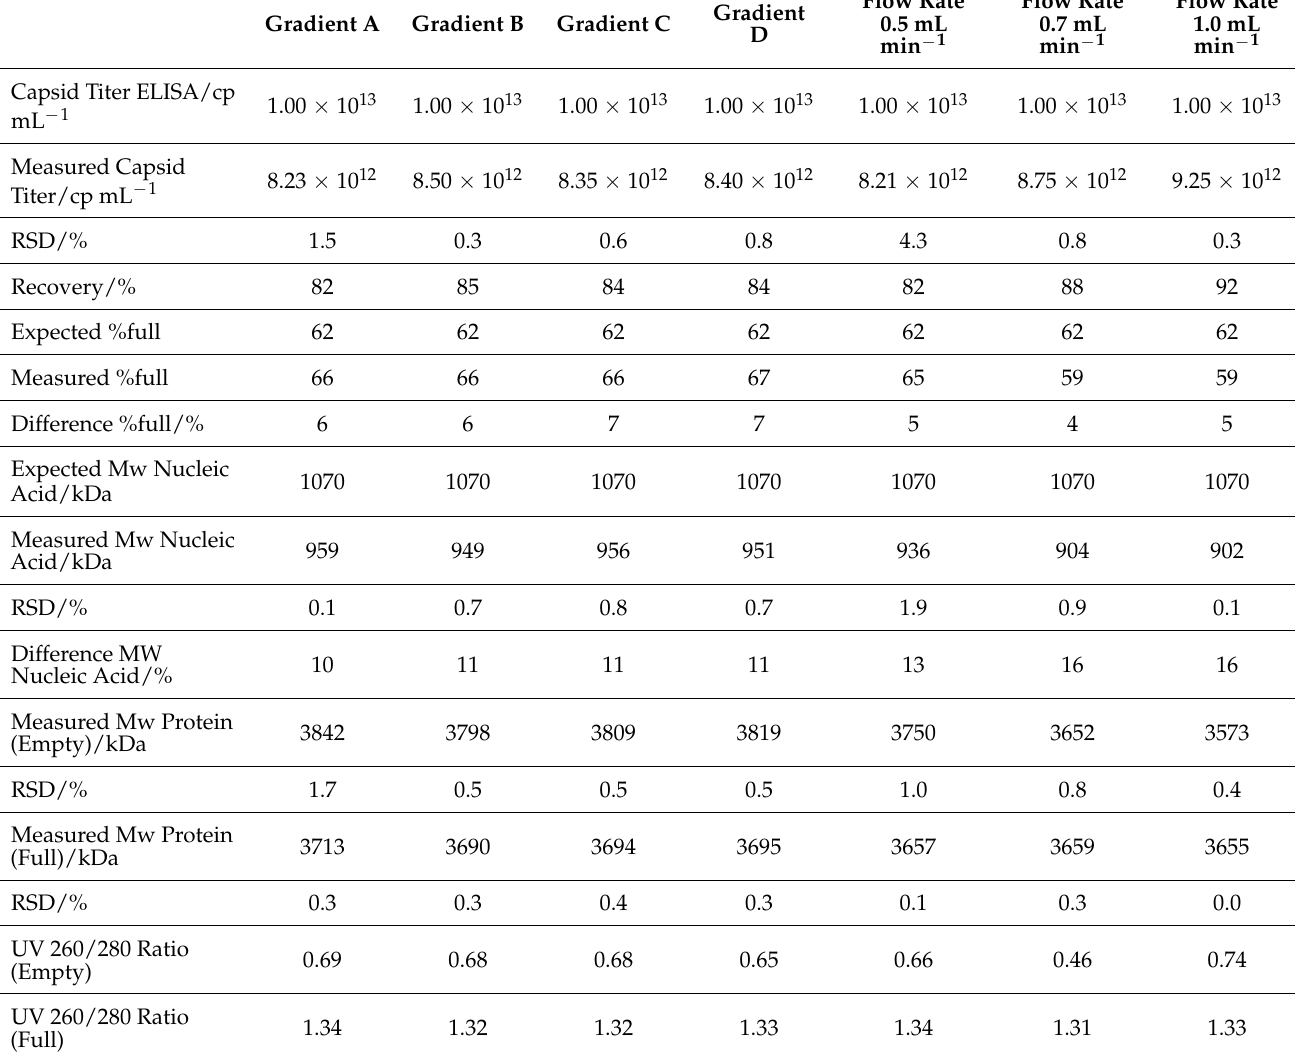
Table 1. Overview of IEC-MALS method performance results of empty and full AAV8 capsids obtained by varying the gradient steepness and flow rate of the developed IEC-MALS